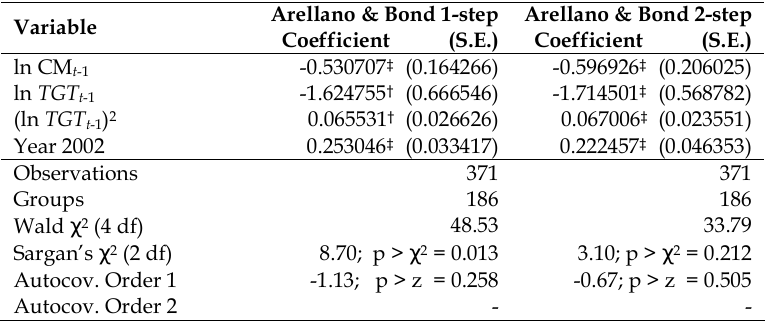
Table 4. Results from 1-step and 2-step Arellano & Bond dynamic panel data estimators for infrastructure maintenance costs - Model IIIa and